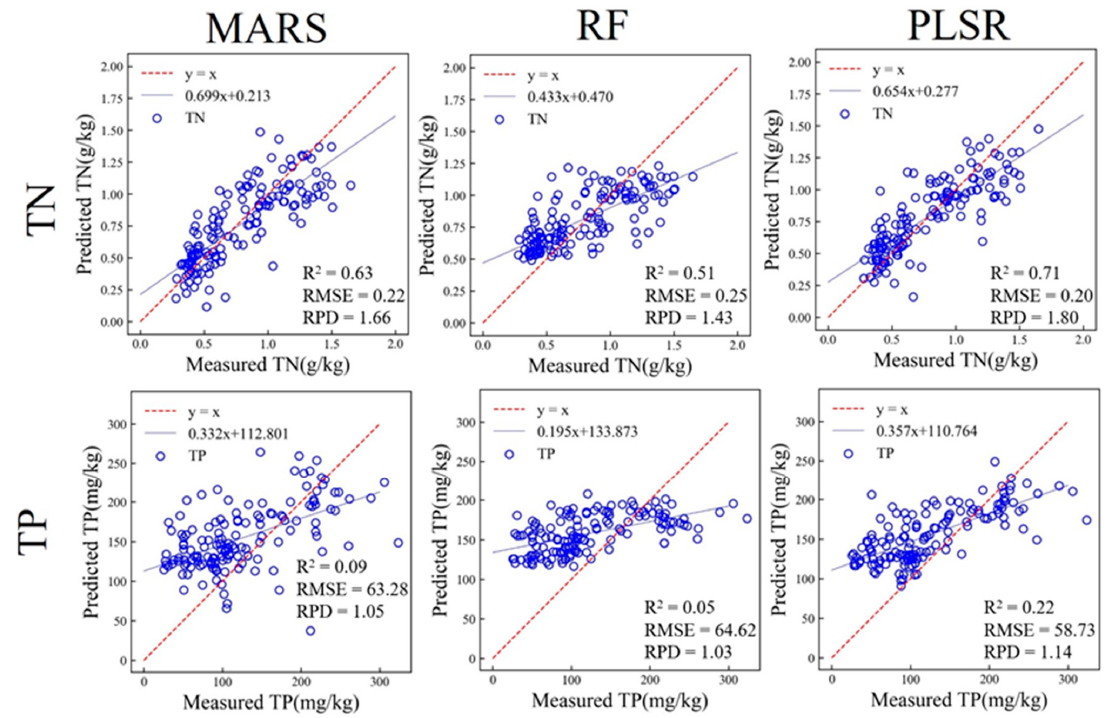
Figure 7. Sca tt er plot of predicted soil TN and TP based on in situ MIR. Figure 7. Scatter plot of predicted soil TN and TP based on in situ